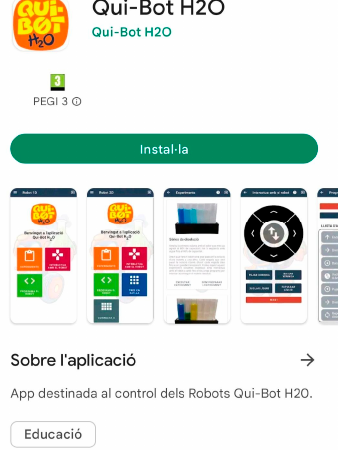
Figure 4. The Qui-Bot app [28,29] (Google Play).